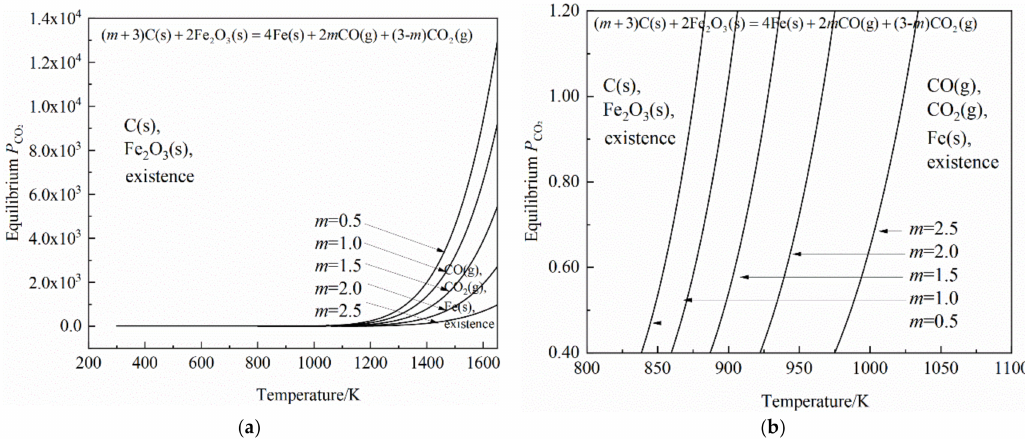
Figure 10. The equilibrium relative gas partial pressure of CO 2 as a function of temperature of the reaction of ( m + 3)C(s) +